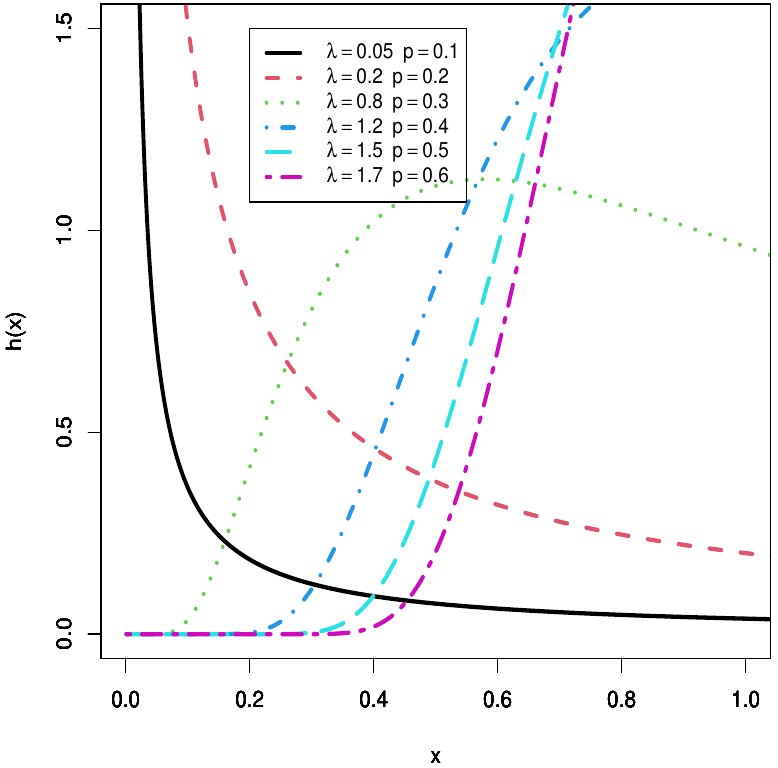
Figure 4. Different shapes of hrf for FB distribution at β = 1.5 and n =